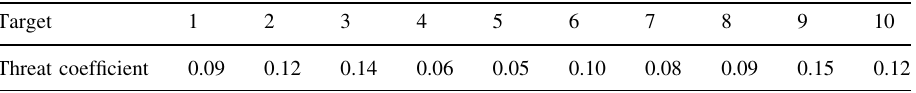
Table 6 Target threat coefficient for case 3